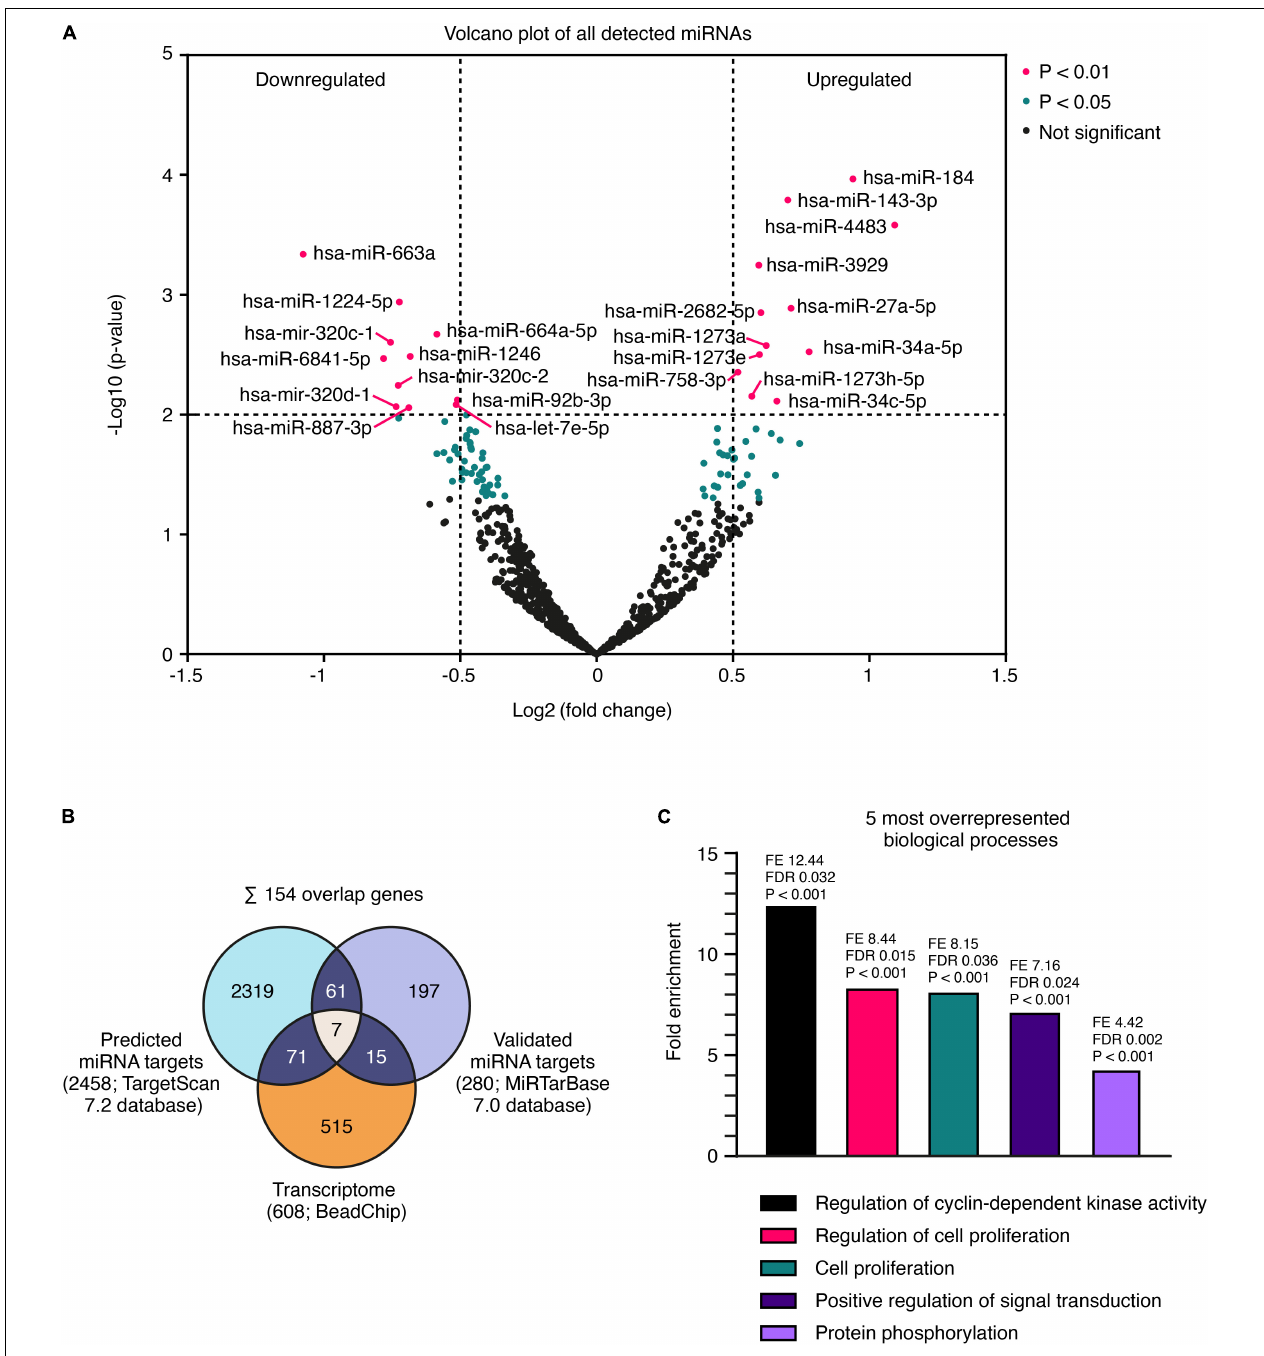
FIGURE 3 | miRNome-wide screen and overlap analysis with transcriptome data. (A) Volcano plot shows 796 detected miRNAs in SNCA vs. GFP overexpressing LUHMES neurons 4 days after adenoviral transduction. 55 miRNAs with P < 0.05 and 23 with P < 0.01 were differentially expressed (non-adjusted p-value). (B) Identification of 154 overlap genes of predicted miRNA target genes (TargetScan 7.2 database) and experimentally validated target genes (MiRTarBase 7.0 database) with miRNAs of P < 0.01, and significantly regulated mRNAs ( P adj < 0.05; Benjamini–Hochberg FDR) from transcriptome analysis (BeadChip). (C) Overrepresented biological processes identified by PANTHER GO-Slim pathway analysis among 154 overlap genes.